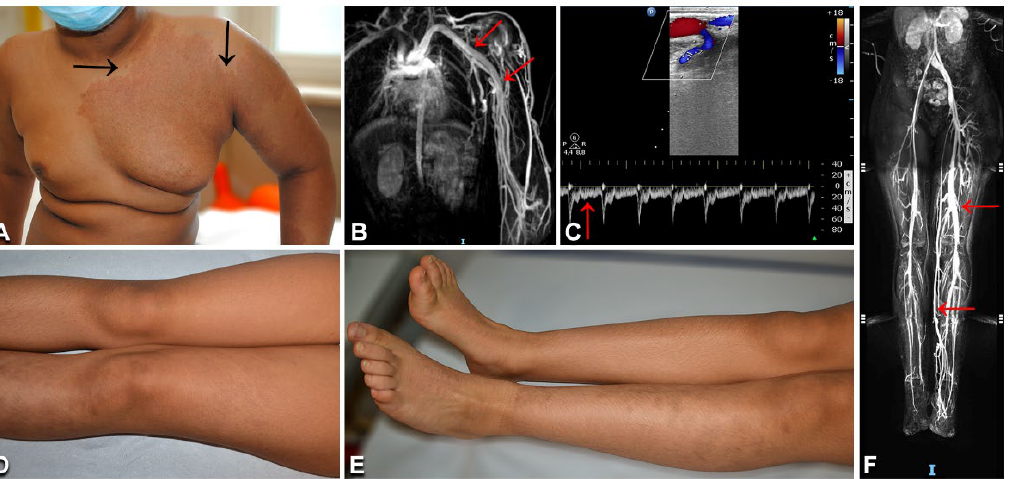
Figure 10. Clinical and imaging characteristics of Parkes Weber syndrome: Left upper limb and thorax reddish patch with pale halo ( A , arrows), and hypertrophy of the affected area ( A ), in an 11-year-old Indian boy (Table 1, n. 42). In the same patient, thoracic and upper limb MRI shows humeral and subclavian vein ectasia (arrows in B ); Doppler ultrasound documents an arteriovenous shunt and vein ectasia ( C ), as well as arterial high diastolic flow (arrow in C ). A 12-year-old Moroccan girl (Table 1, n. 43) presents multiple brownish patches on the left lower limb, with ipsilateral overgrowth ( D , E ). Abdominal and lower limb MRI documents ectatic veins ( F , arrows).